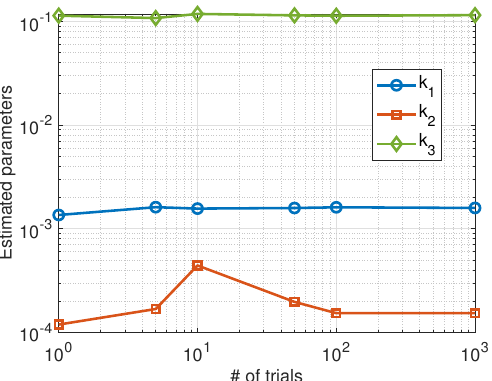
Figure 5. Average values of the parameters estimated using the Nelder–Mead algorithm as a function of the number of trials.